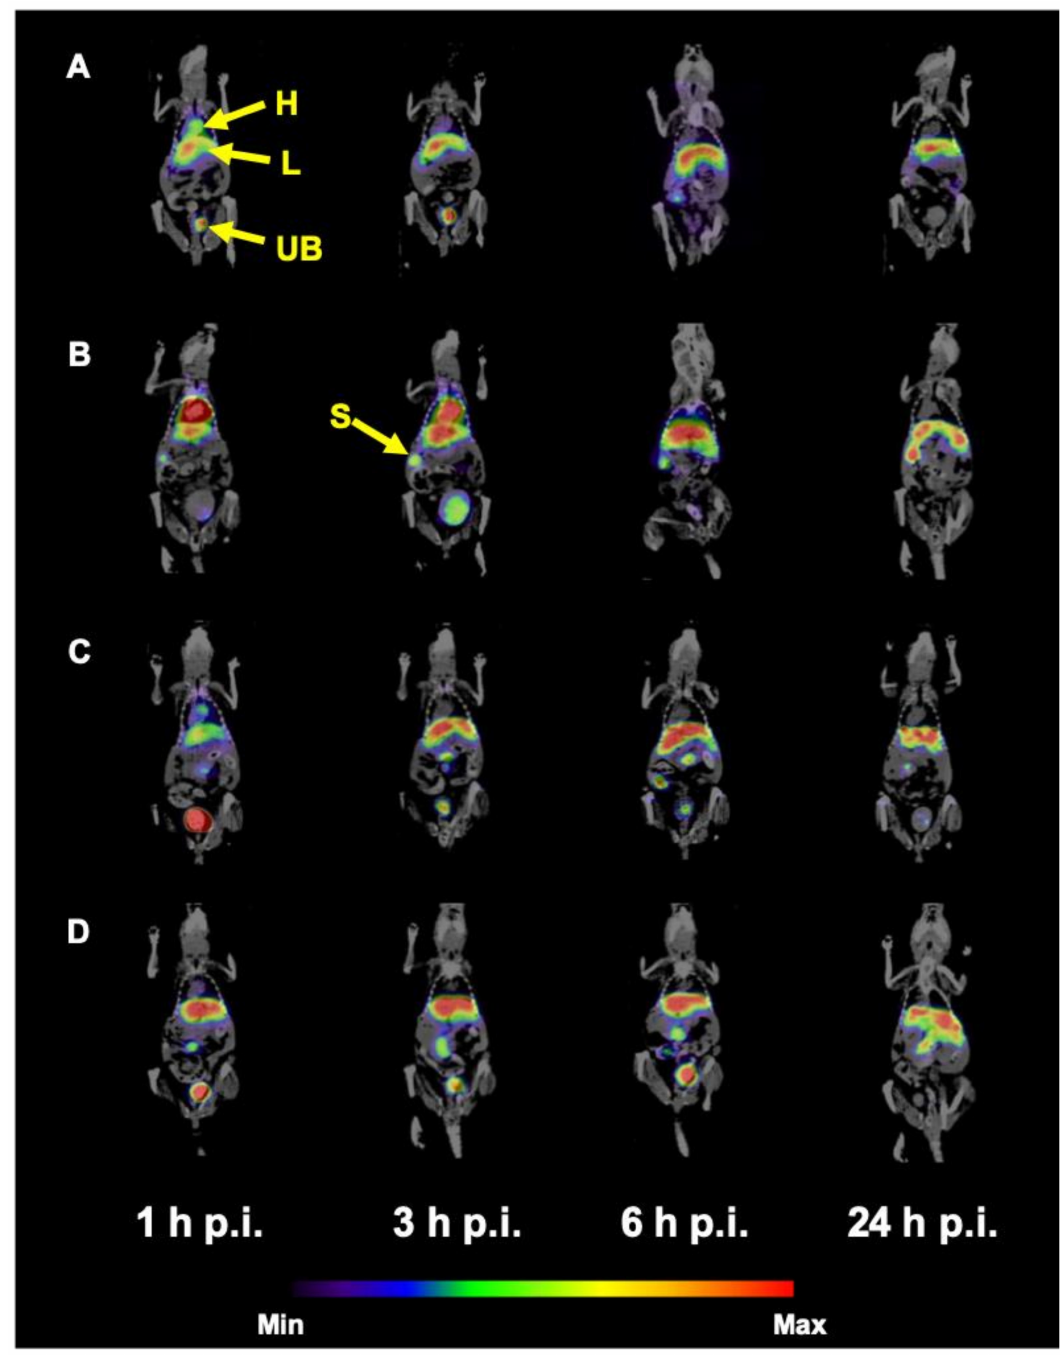
Figure 7. Coronal slices of SPECT / CT imaging of 99m Tc-HEDP labeled HAP NPs in Balb / c mice 1, 3, 6 and 24h p.i. after r.o. injection ( 99m Tc-PEG2000-HAP ( A ), 99m Tc-PEG5000-HAP ( B ), 99m Tc-POX5000-HAP ( C ), 99m Tc-POX10000-HAP ( D ); H = heart, L = liver, UB = urinary bladder, S =